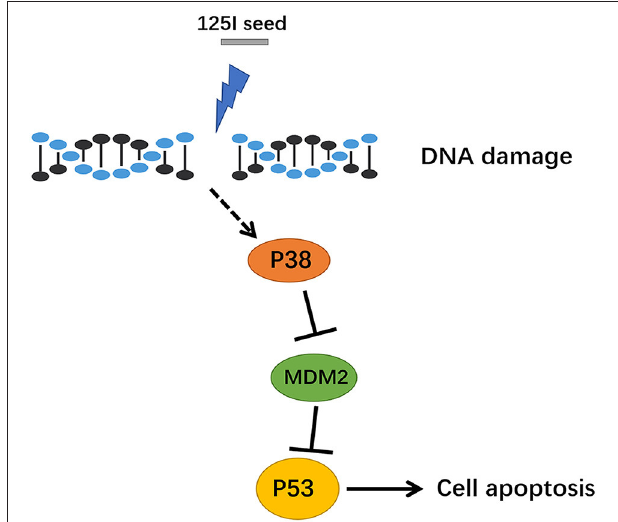
FIGURE 6 | The signal path diagram of p38 MAPK/MDM2/p53. After treatment with 125 I seed, MDM2 was downregulated, and the combination of MDM2 and p53 was reduced, which resulted in a stable transcription of p53. The p53, which has transcription activity, went into the nucleus via the activation of downstream apoptotic proteins, which eventually contributed to